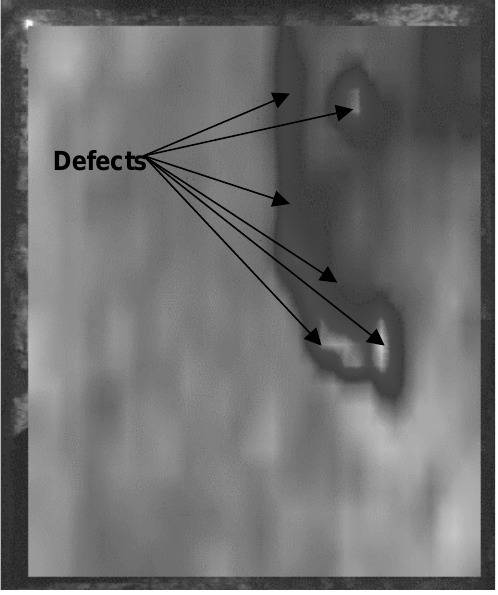
Fig.17. TheRMSmapofFRFsmeasured onthe icon inthe 0–50kHz